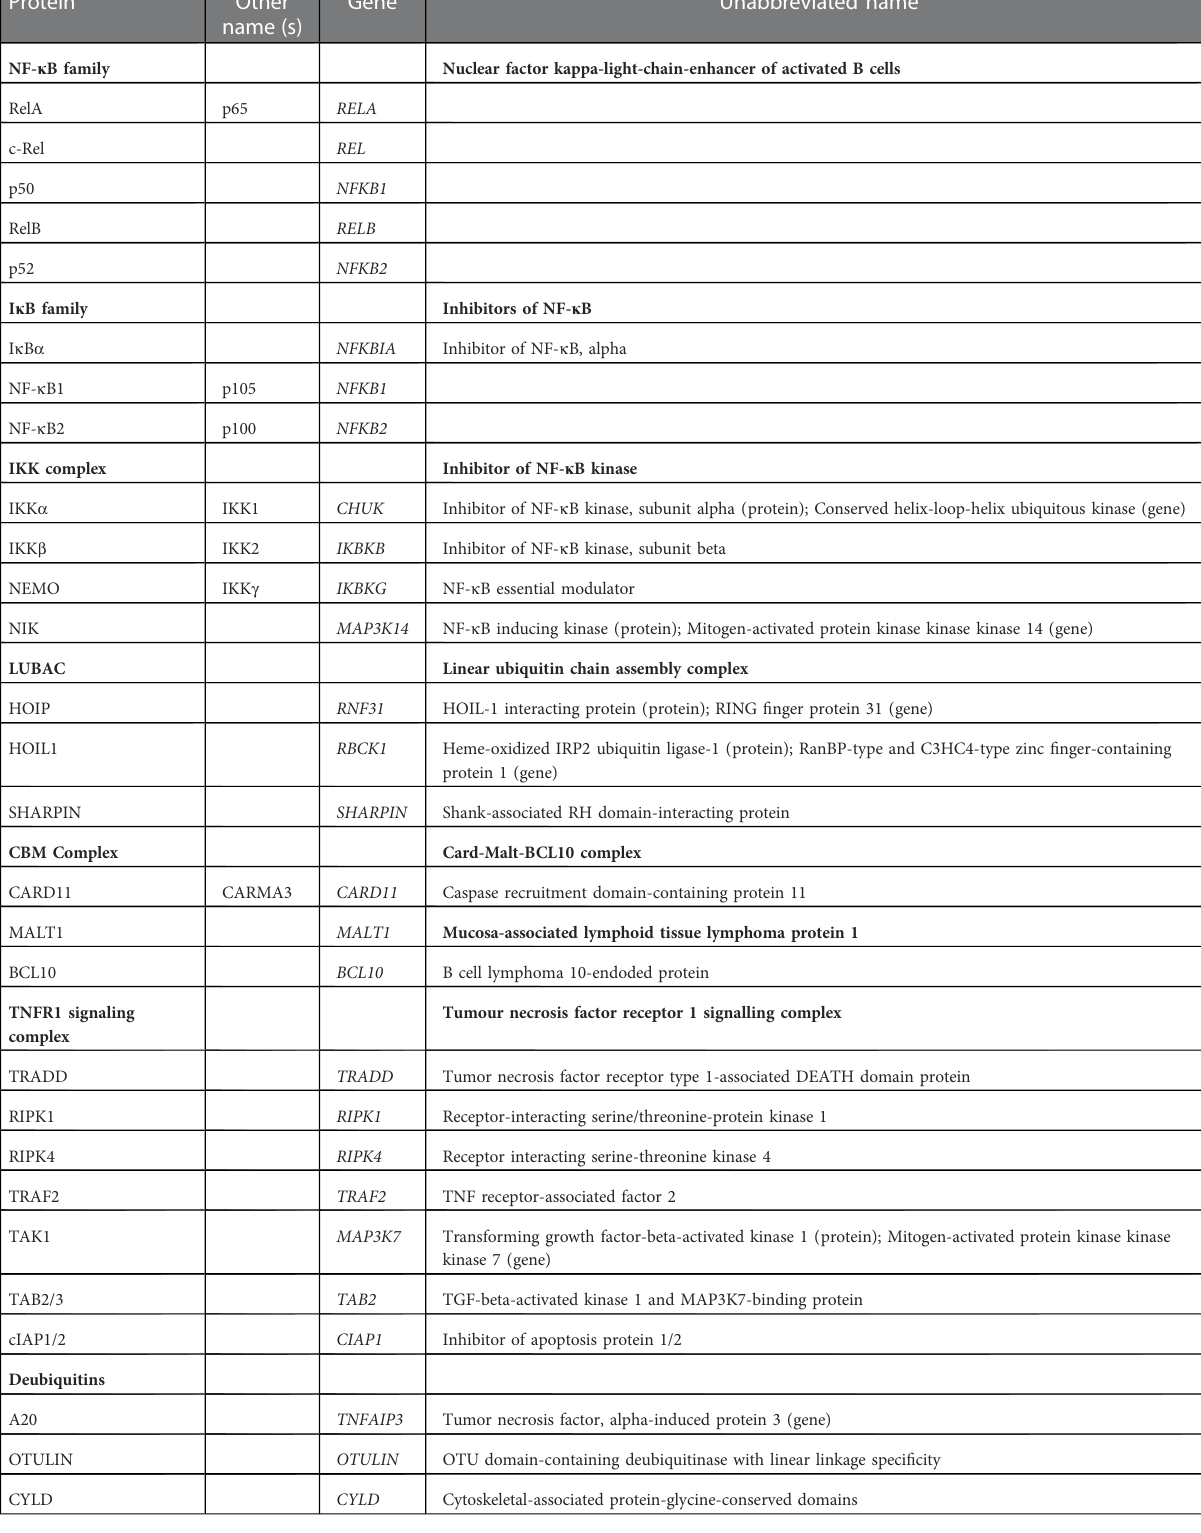
TABLE 1 Summary of NF- κ B proteins and their